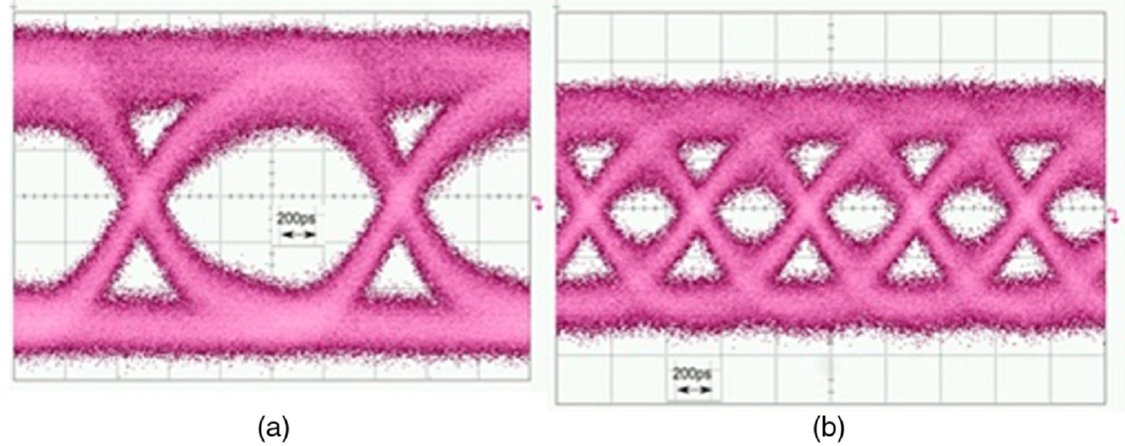
Figure 3. Eye diagrams at ( a ) 1 Gbit/s and ( b ) 2.5 Gbit/s at the photoreceiver output.